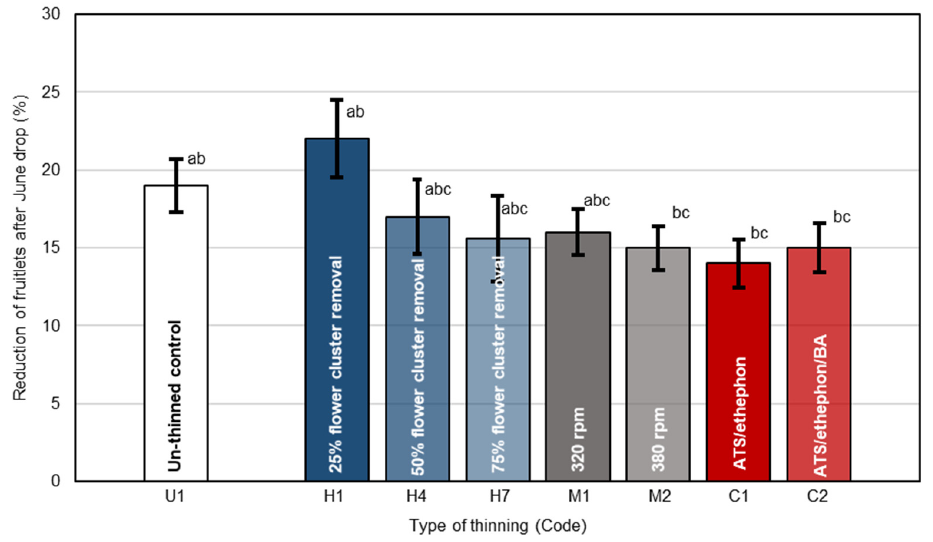
Figure 7. Effect of practical thinning methods on reduction of fruitlets in June drop expressed as difference between before and after June drop (color coding and explanations as for Figure 3).